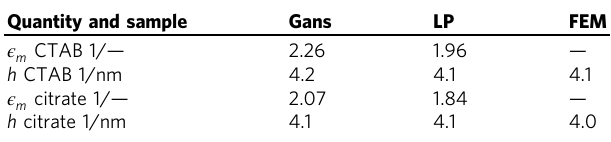
Table 1 List of adjusted parameters Quantity and sample